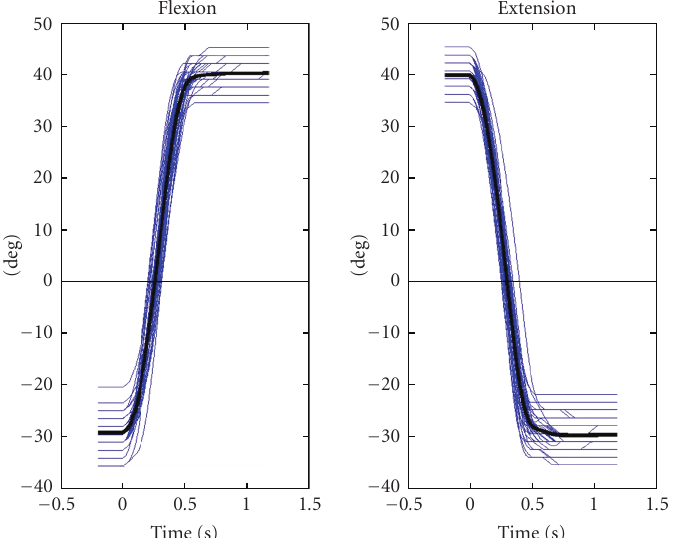
Figure 2: Time courses of the angular movements executed by one subject. The displayed traces are synchronized in time according to the procedure described in Section 2 . Therefore, by definition, movement started at time zero. The thicker black line indicates the